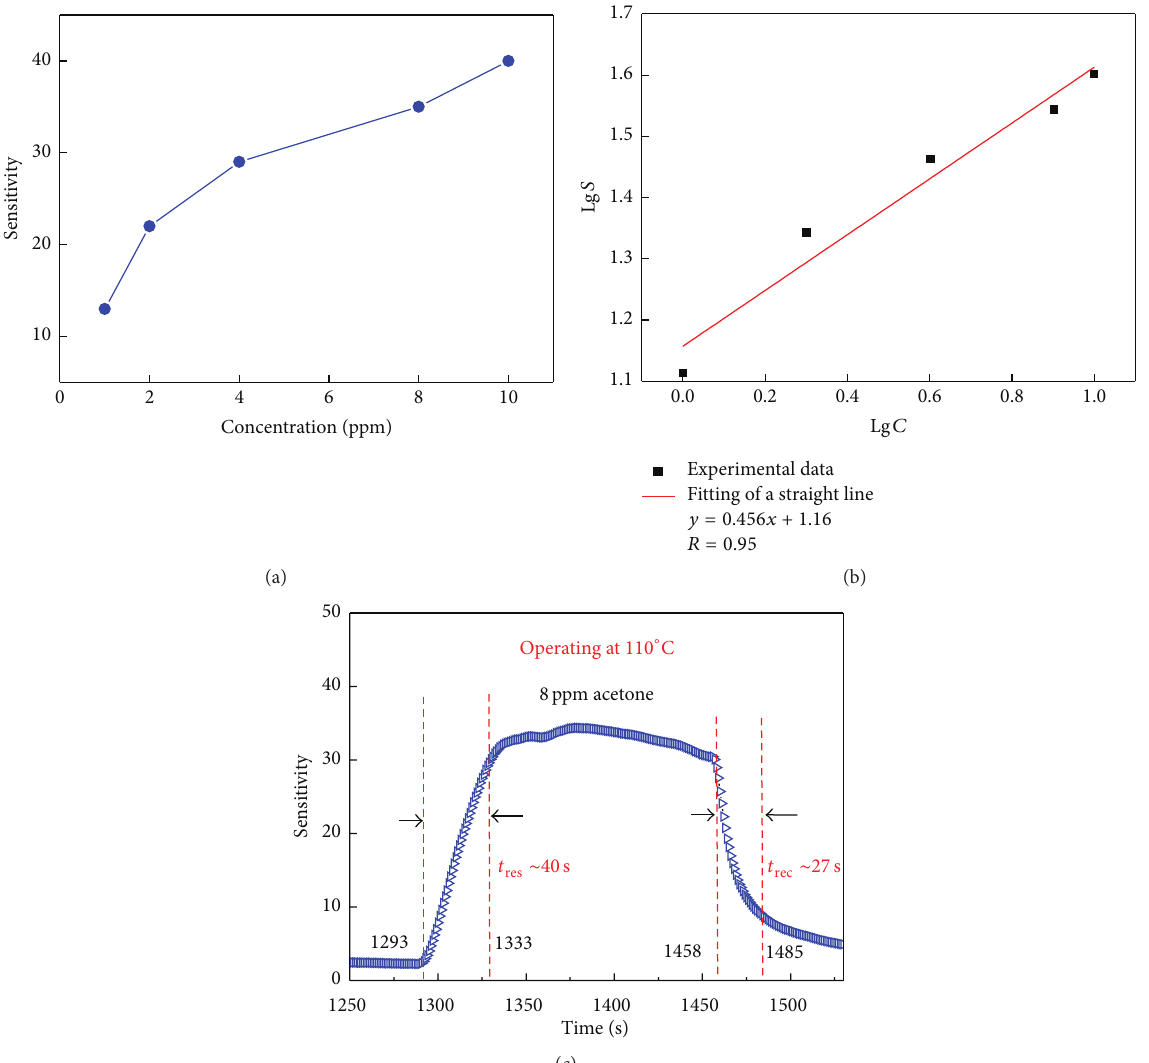
Figure 4: (a) Sensitivity of flower-shaped WO 3 to different concentrations of acetone at 110 ∘ C. (b) Logarithmic linear fitting of sensibility and )andrecovery( 𝑡 )timemeasuredfromtheresponse-timedatato8 ppmacetoneatanoperatingtemperature concentration.(c)Response( 𝑡 res rec of 110 ∘